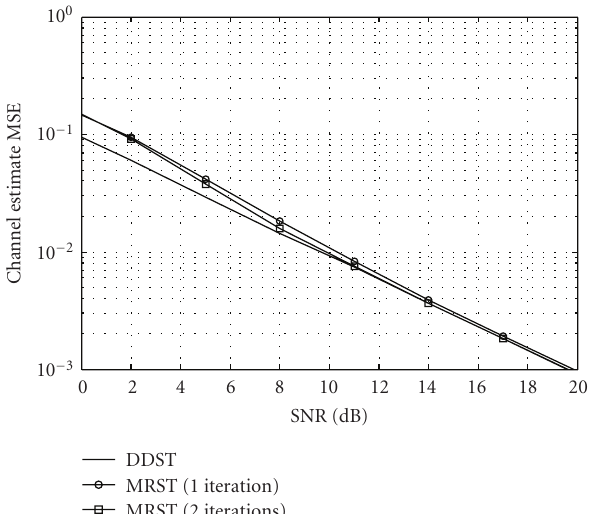
Figure 7: Channel estimate MSE of G 2-OSTBC 2 × 2.